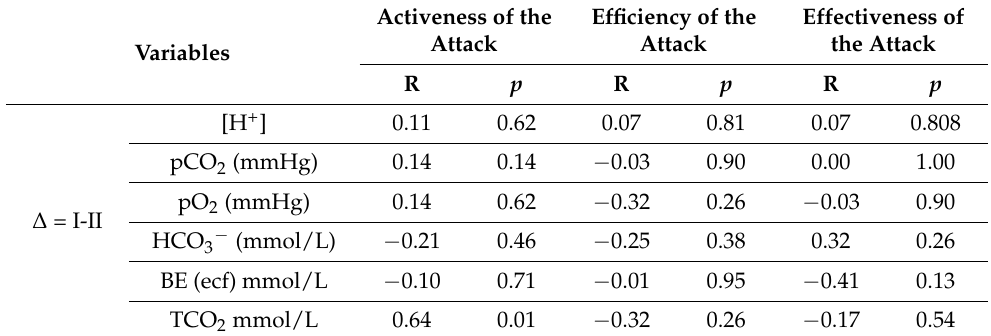
Table 4. Matrix of correlation coefficients between examined